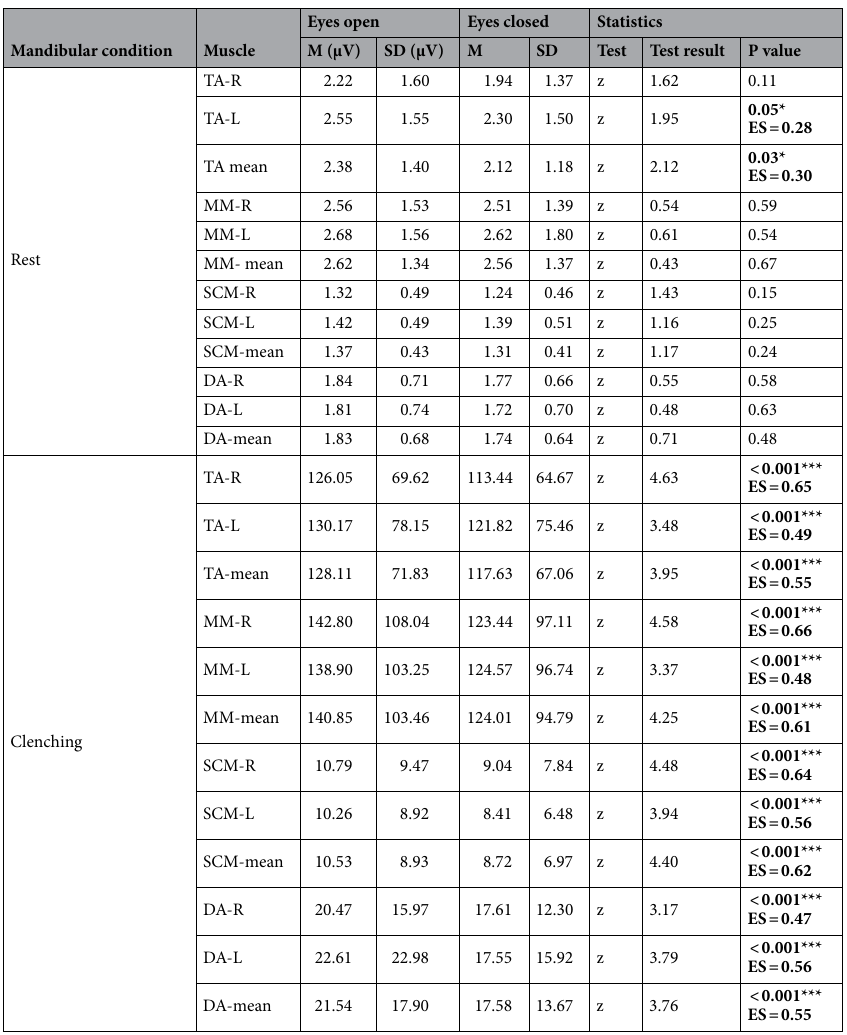
Table 1. Presenting summary of the results of bioelectrical activity (rest and clenching) of the studied muscles. Significant values are in bold. TA the front part of the temporalis muscle, MM the superficial part of the masseter muscle, SCM the middle part of the sternocleidomastoid muscle, DA the anterior belly of the digastric muscle, R right site, L left site. Significant difference: *p ≤ 0.05, **p ≤ 0.01, ***p ≤